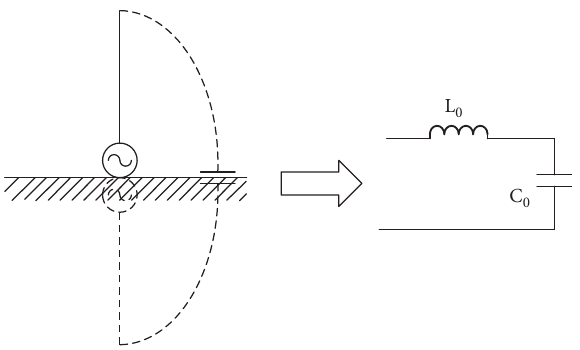
Figure 9: Equivalent circuit of conventional monopole antenna.